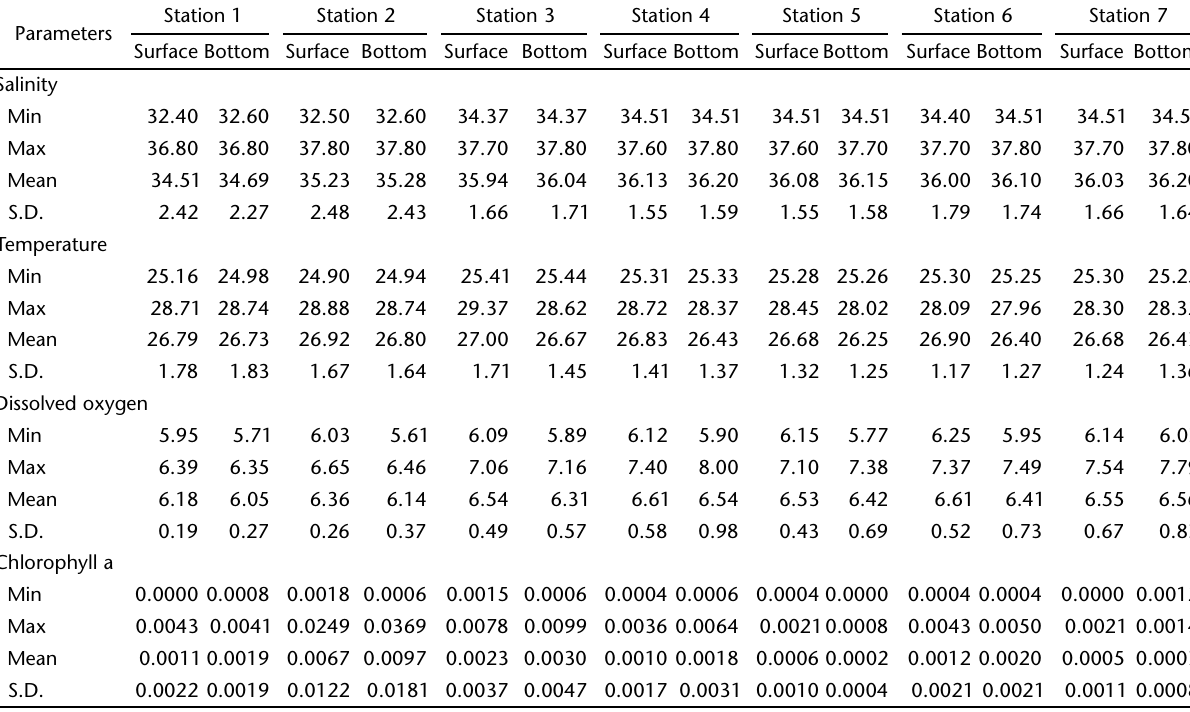
Table I. Minimum, maximum, mean and standard deviation of the salinity, temperature (ºC), dissolved oxygen (mg.l -1 ) and Chlorophyll a (mg.m -3 ) of the sampling stations during the entire sampling period in the Caravelas River estuary and the adjacent coastal region. Station Parameters